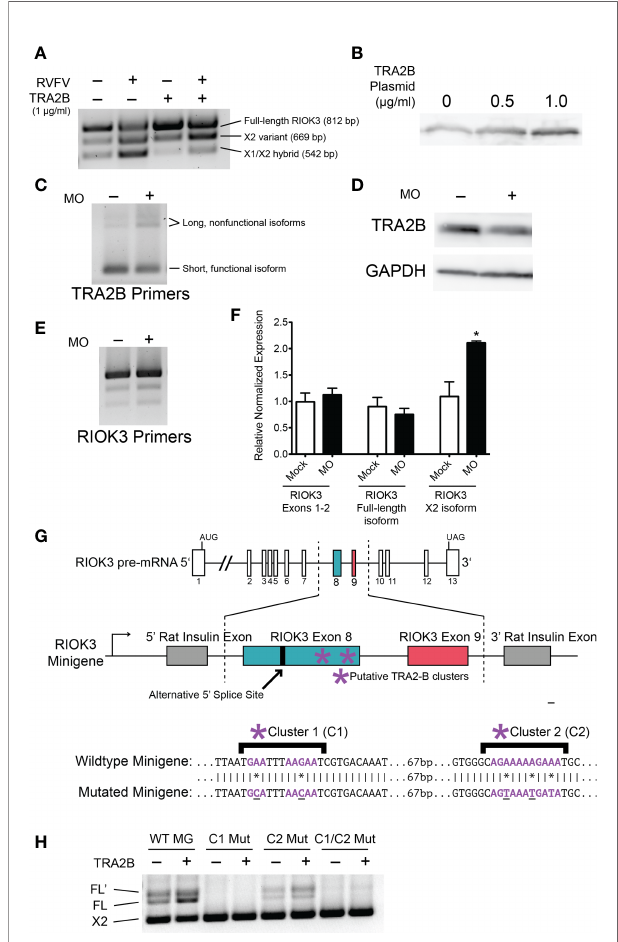
FIGURE 3 | RIOK3 mRNA alternative splicing bias is controlled by TRA2- b . (A) HEK293 cells were transfected with TRA2- b overexpression plasmid or GFP control for 24h, then infected with RVFV MP-12 (MOI = 1) or mock for 24h before harvesting. RT-PCR shows RIOK3 splice isoforms. (B) HEK293 cells were transfected with TRA2- b overexpression plasmid. 24h post-transfection, cells were lysed and a western blot was performed to estimate overexpression. (C) HEK293 cells were treated with TRA2- b poison exon-inducing morpholino oligonucleotides (MO) at 10 m M for 24h, and RT-PCR was performed using TRA2- b primers. (D) HEK293 cells were treated with 5 m M MO for 24h, and lysate was used for a western blot to estimate knockdown of TRA2- b . (E) HEK293 cells were treated with MO as in panel C, and RT-PCR was performed using primers against RIOK3. (F) HEK293 cells were treated with MO as in panel C and RNA was used to perform RT-qPCR. RIOK3 exons 1-2 were used to measure overall expression of the mRNA. Each lane indicates data from biological triplicates and technical duplicates. Asterisk indicates p < 0.05 compared to mock transfection (Student ’ s t-test). (G) Schematic illustration of RIOK3 splicing minigene. RIOK3 exons 8 and 9 were cloned into pSpliceExpress vector, and primers spanning the splice junction between the rat insulin exon and the RIOK3 exon were used to amplify cDNA for RT-PCR. Lower panel shows mutations in putative TRA2- b binding sites. (E) RT-PCR using splice junction-spanning primers to amplify minigene